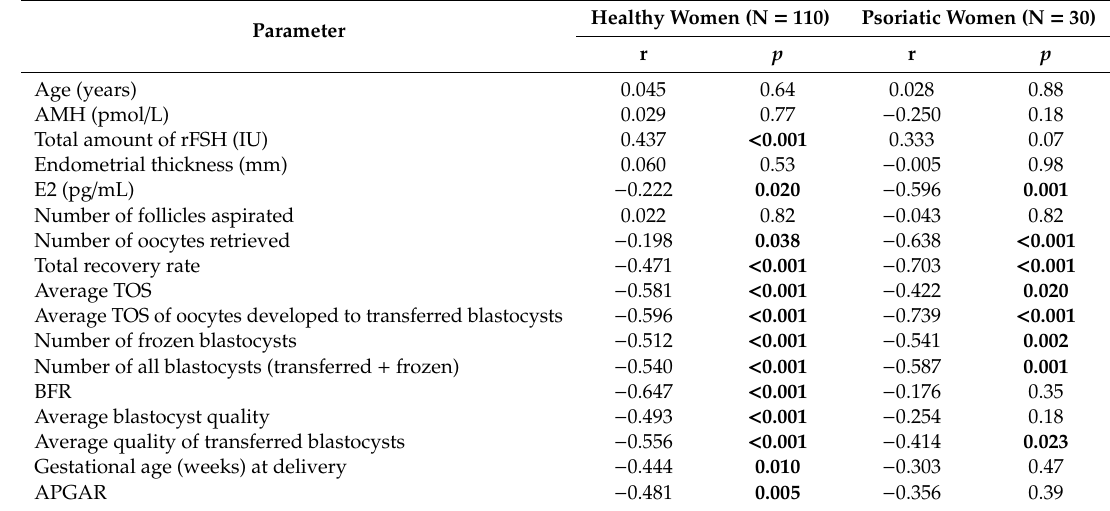
Table 3. Correlations of BMI (kg / m 2 ) with age, AMH, the course of ICSI procedure, pregnancy termination and APGAR in healthy women, and in psoriatic